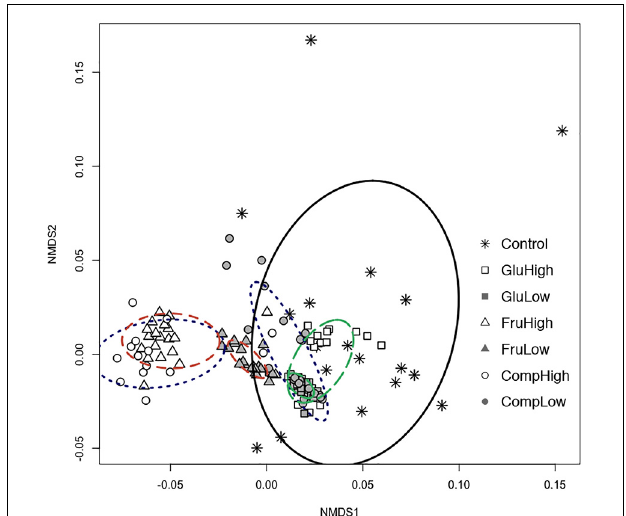
FIGURE 1 | Non-metric multidimensional scaling (NMDS) based on carbon nutrient use profiles in Biolog SF-P2 plates for Streptomyces isolates from carbon-amended (glucose-high dose, open square; glucose-low dose, solid square; fructose-high dose, open triangle; fructose-low dose, solid triangle; complex-high dose, open circle; complex-low dose, solid circle) and non-amended (control, asterisk) soils after 72 h incubation period. Ellipses connect and define the centroids of communities from different carbon amendment treatments (glucose, green and long-dashed; fructose, orange, and dashed; complex, blue and dotted; non-amended control, black and